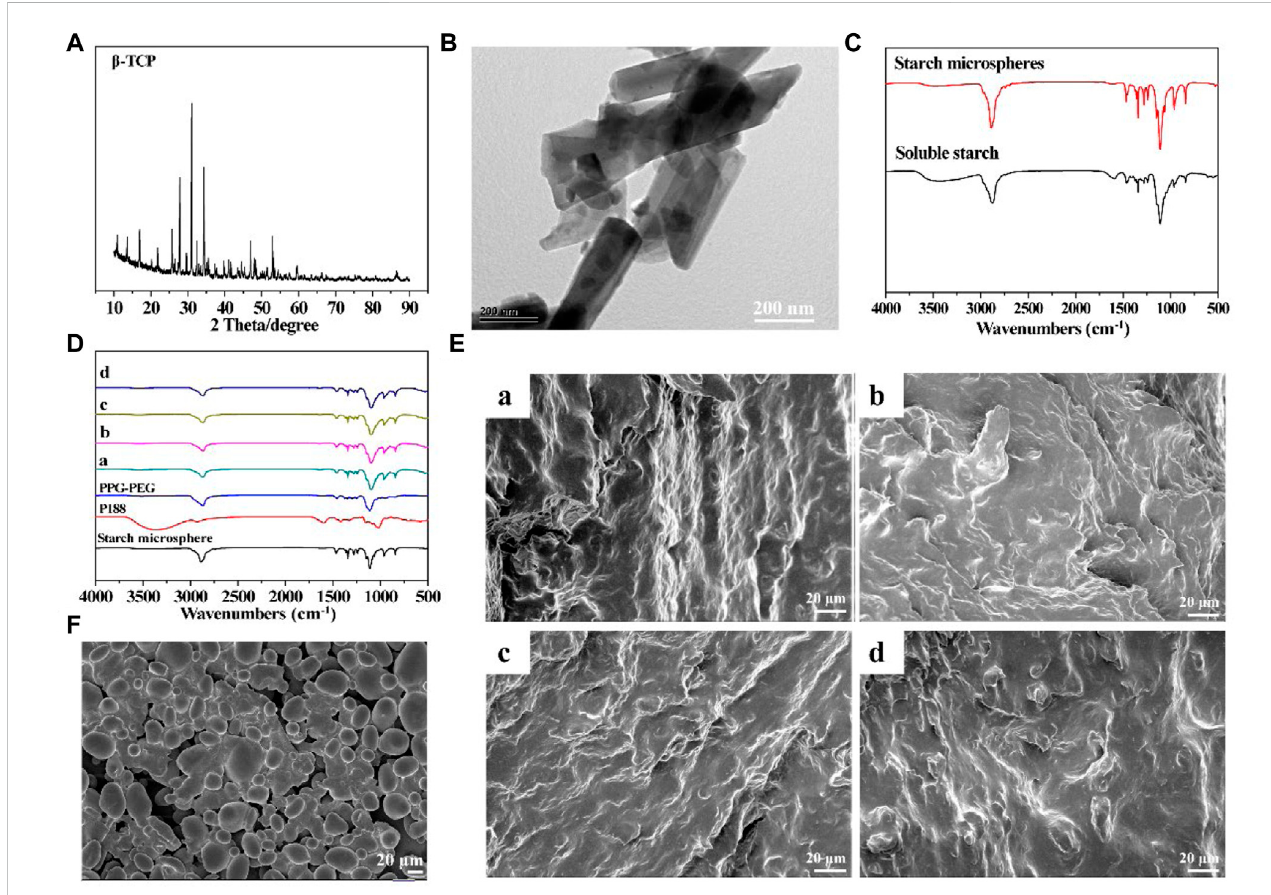
FIGURE 1 Characterization of prepared resorbable bone wax (A) XRD spectrum of β -TCP. (B) TEM image of β -TCP. (C) FTIR spectra of soluble starch and starch microspheres. (D) FTIR spectra of bone waxes with different components. (E) Morphology of bone waxes a, b, c and d. (F) SEM image of starch